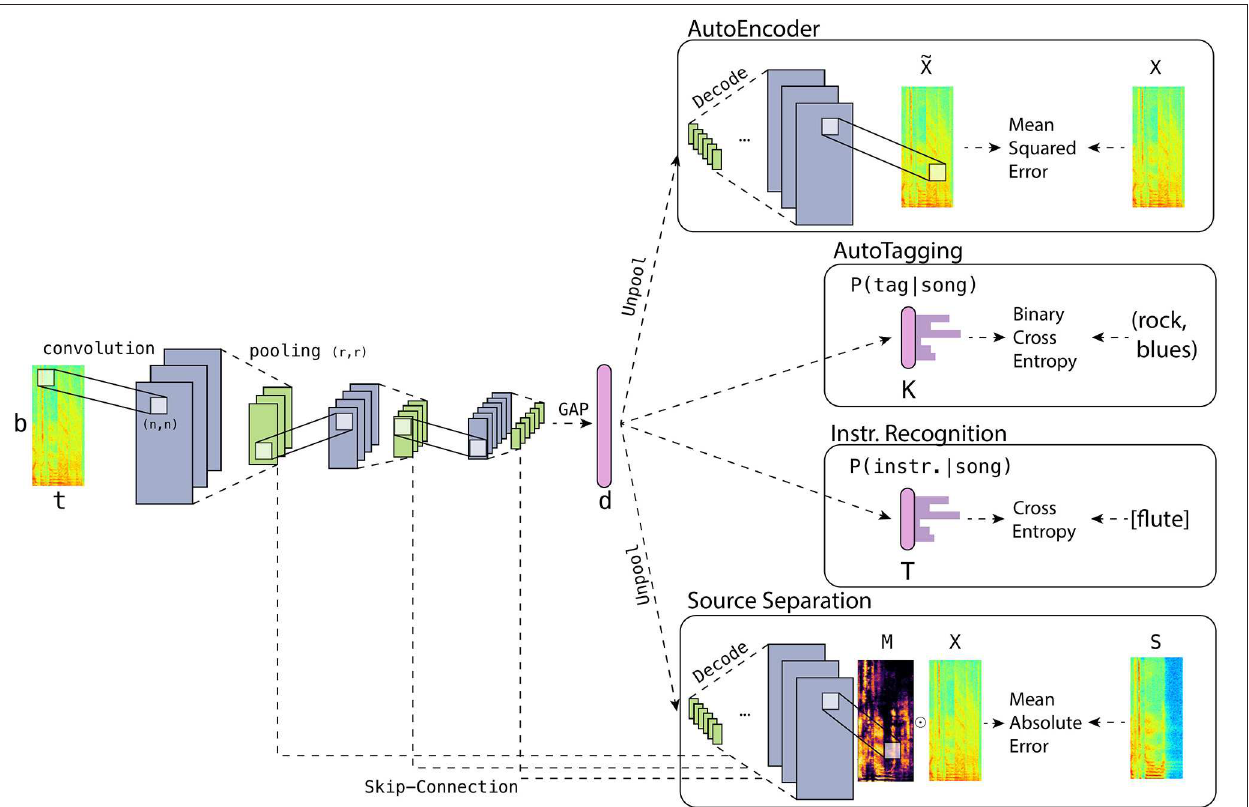
FIGURE 2 | Network architecture used in this work. The left half of the model is the encoder pipeline f , whose architecture is kept the same across all the tasks of our experiments. The pink vertical bar represents the latent vector z , in which all the measures we propose are tested. The right half of the diagram refers to the four different prediction pipelines with respect to the tasks. The top block describes the decoder and the error function of the task (where, for simplicity, detailed illustrations of decoder g of f are omitted). The second and third block represent the AT and IR task, respectively. Here, the smaller pink bar represents the terminal layer for the prediction of the posterior distribution for K music tags or T musical instruments. Finally, the lowest block is describing the mask predictor g , prediction process and the way the error function is calculated. Also, this architecture includes the skip-connections from each convolution block of the encoder, which is the key characteristic of the U-Net [